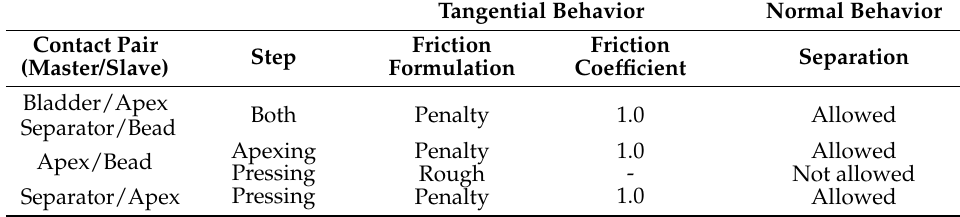
Table 2. Interaction properties.